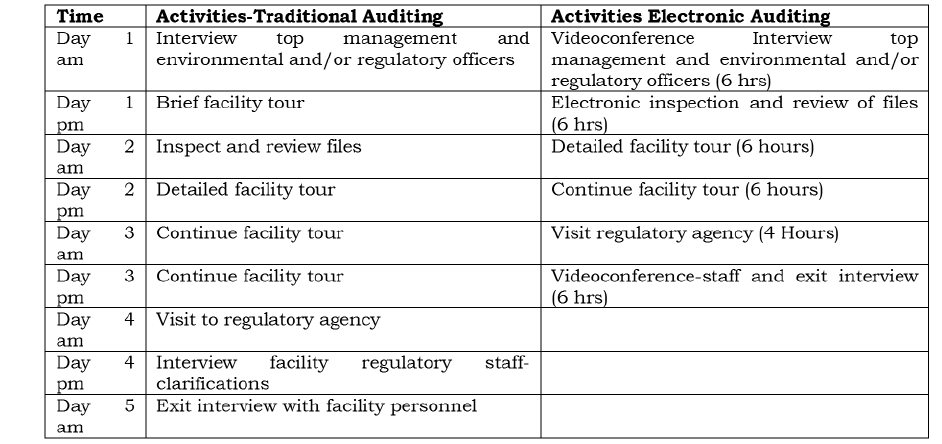
Table 2 Time line for typical traditional and proposed electronic audit